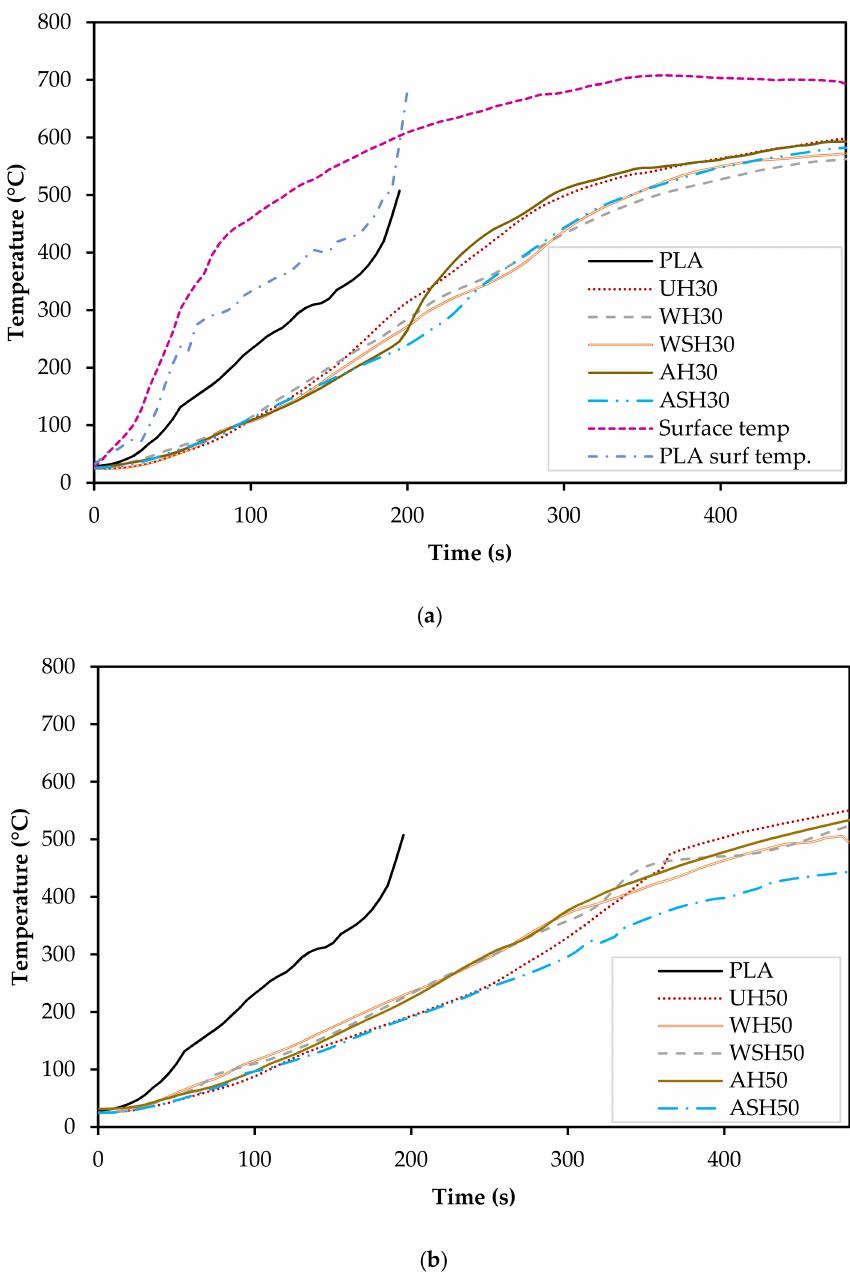
Figure 8. Surface temperature and temperature response behind the neat PLA and composites at ( a ) 30%;( b ) 50% hemp fiber